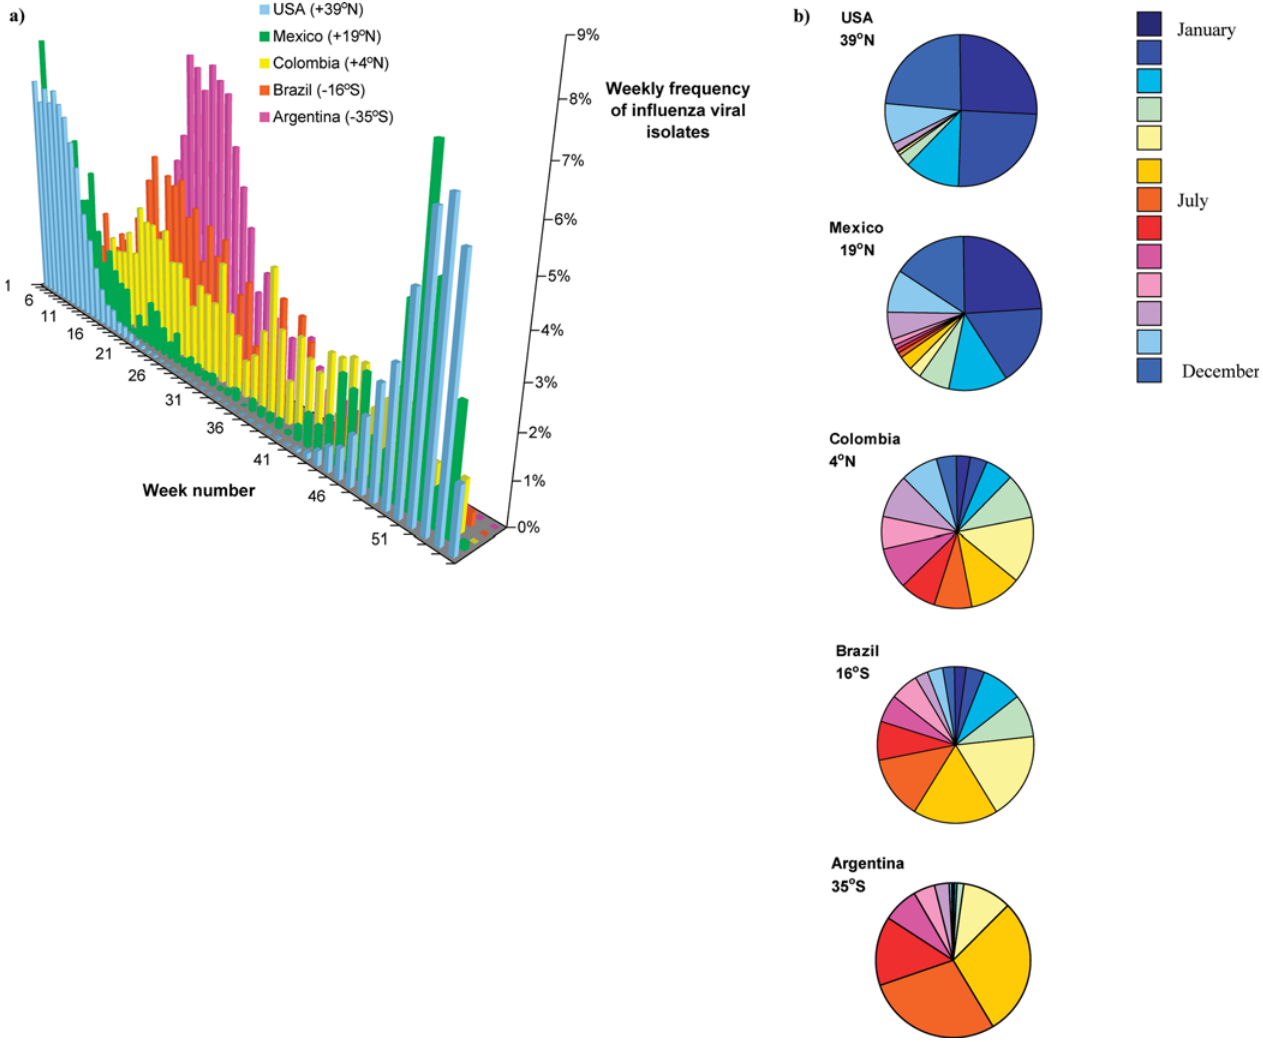
Figure 1. Comparison of Infl uenza Seasonal Patterns in Temperate and Tropical Countries in the Americas (From Lat +39˚N to −35˚S) The latitude of the capital city is indicated for each country in the legend. (A) Weekly distribution of infl uenza laboratory isolates (from week 1 to week 52; weekly frequency ( y -axis) is calculated as the weekly number of isolates divided by the annual number of isolates). (B) Weekly numbers of isolates were aggregated over four-week periods to show a (nearly) monthly distribution of infl uenza circulation. Each color represents a different month (color bar on the right). Note the transition in seasonal patterns from north to south, ranging from marked seasonal winter activity centered around January in the US, to uniform circulation throughout the year in Columbia and again, strong winter epidemics center around July in Argentina. Infl uenza viral surveillance data compiled from WHO